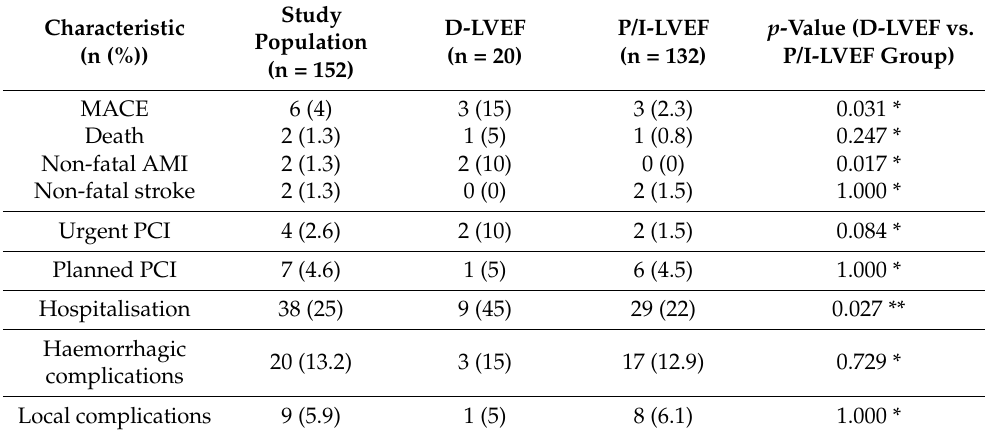
Table 3. Prevalence of MACE and other adverse events among the D-LVEF and P/I-LVEF groups.